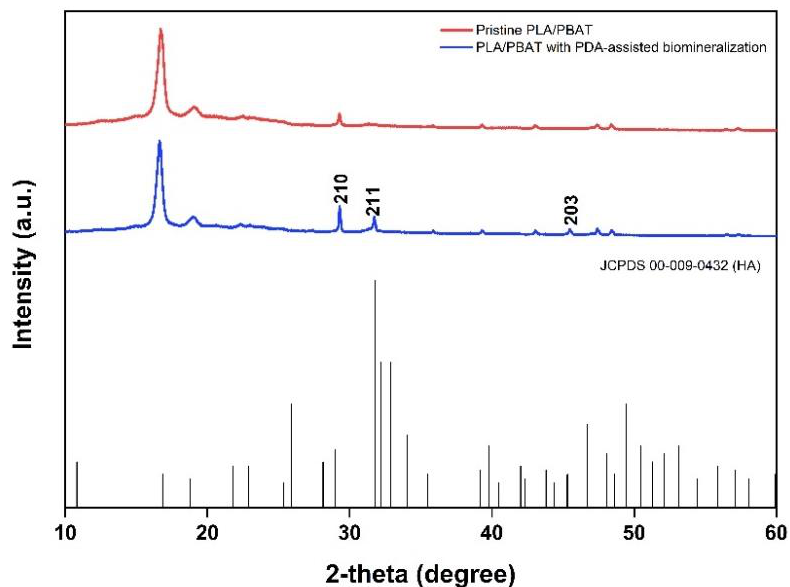
Figure 10. The XRD patterns of the pristine PLA/PBAT, the PLA/PBAT with PDA-assisted biominer- alization layer, and the characteristic peaks related to hydroxyapatite based on JCPDS 00-009-0432.